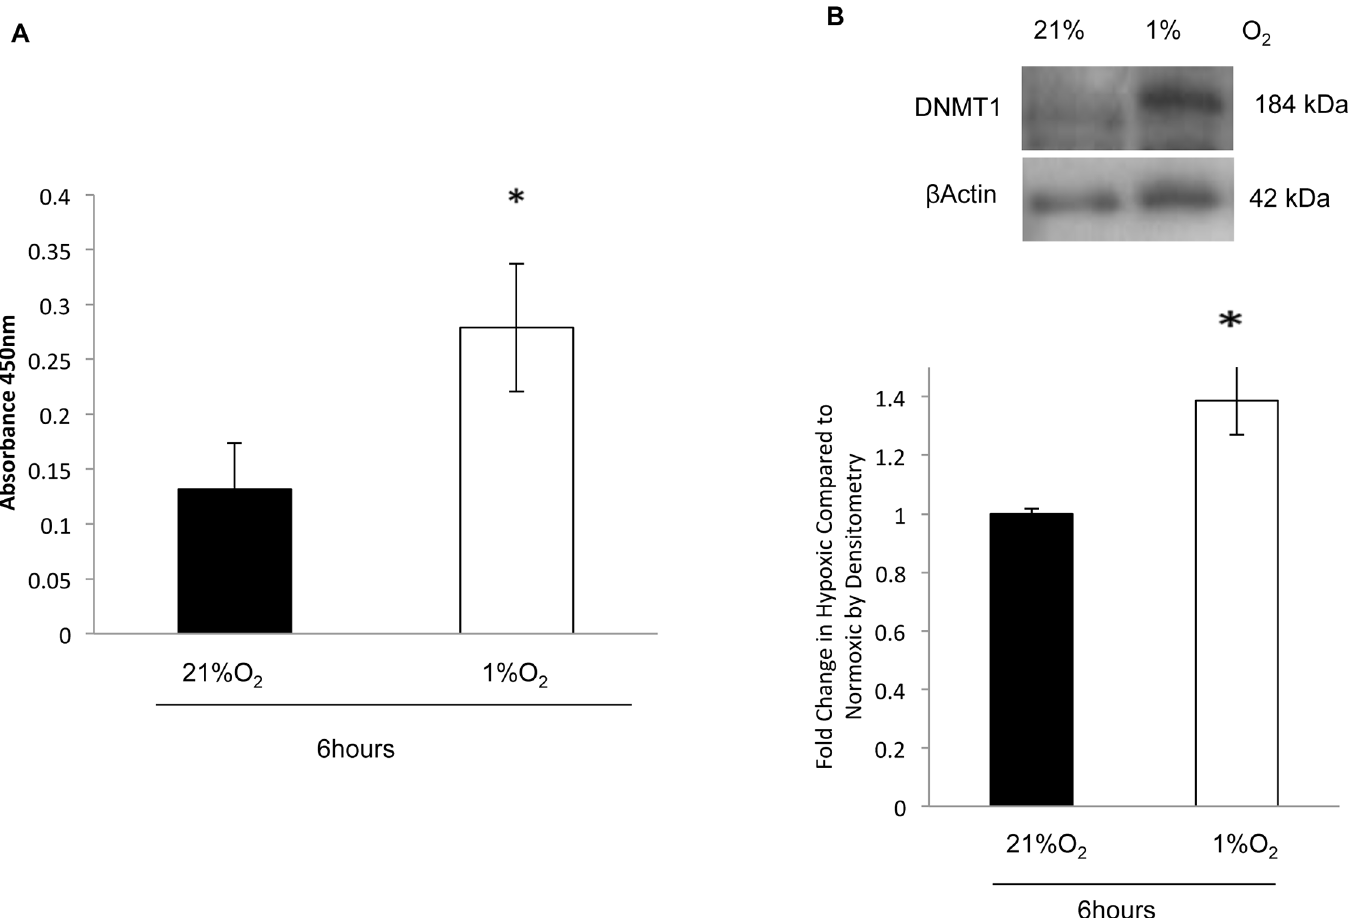
Fig 5. Global DNA methylation and DNMT1 expression were increased in NTM cells subjected to hypoxia. To determine if hypoxia was able to induce a glaucomatous-like phenotype in NTM cells. A. We examined global DNA methylation by ELISA. Global DNA methylation was increased in hypoxic TM cells (1% O 2 ) and normoxic cells (21% O 2 ) after 6 hours. Values were found to be 0.13+/-0.04 (21%O 2 ), 0.28+/-0.06 (1%O 2 ) (p < 0.05). B. We examined protein expression of DNMT1 by Western Blotting in NTM cells subjected to hypoxia, and conducted densitometry on the blots. We found a significant increase in DNMT1 expression after 6 hours hypoxia. n = 3 * P <